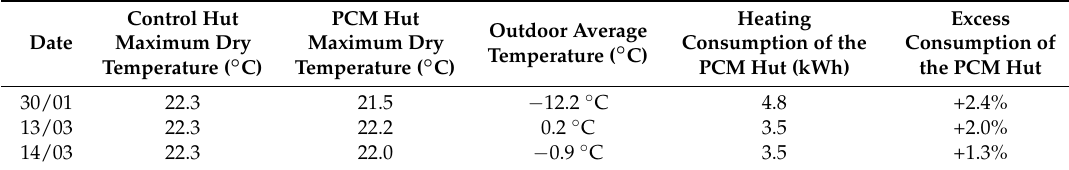
Table 3. Huts behaviour for cloudy cold season days.